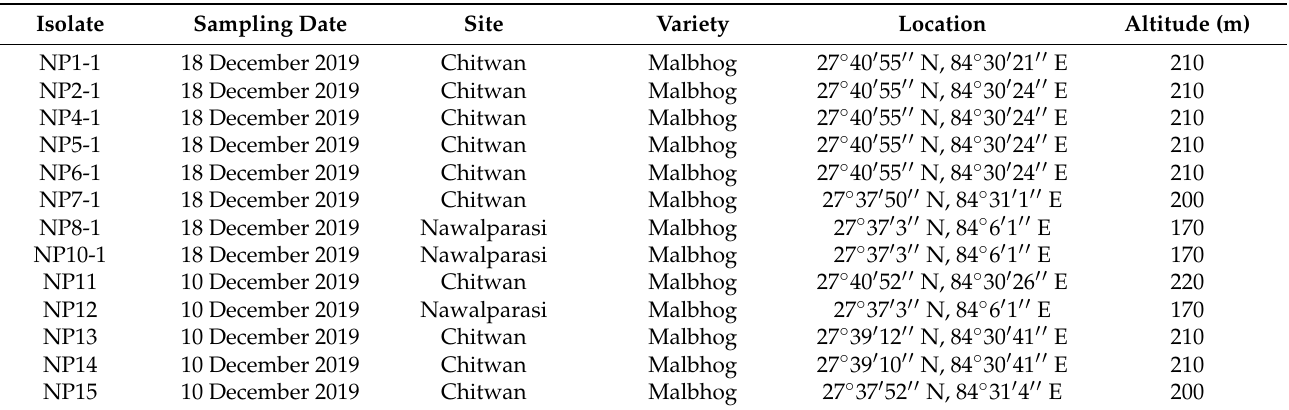
Table 1. Isolates of Fusarium oxysporum used in this study from the Chitwan and Nawalparasi districts of